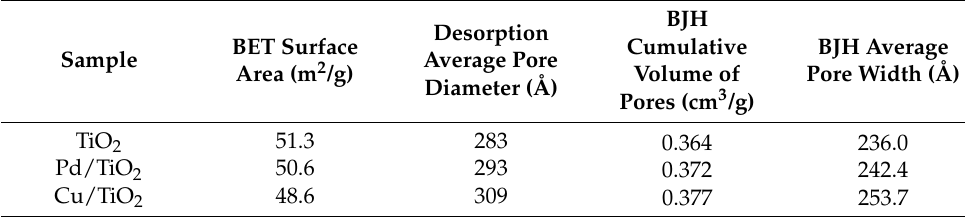
Table 1. The physical properties of Pd/TiO 2 and pure TiO 2.